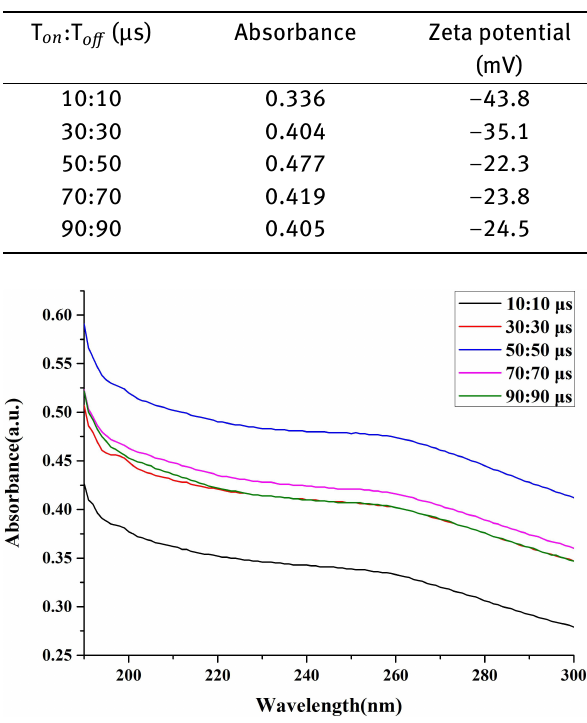
Figure 5: UV-Vis of different T on :T